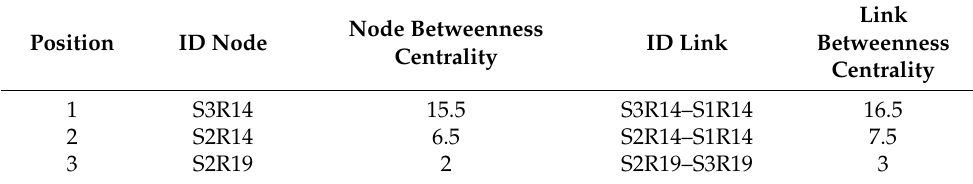
Table 7. Risks and critical interactions according to betweenness centrality. Node Position ID Node